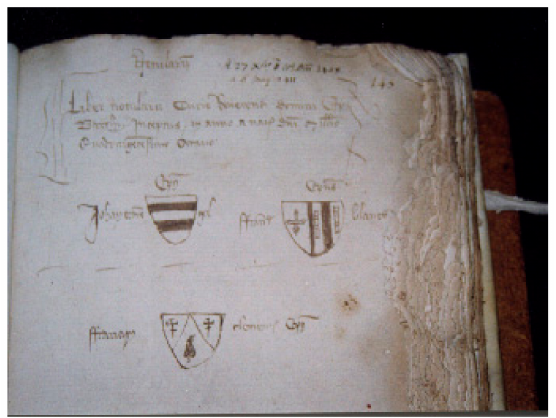
Figure 8. The coat of arms of Bishop Francisco Clemente Sapera (1410–1415) at the collection of codex files Communium of the diocesan archive of